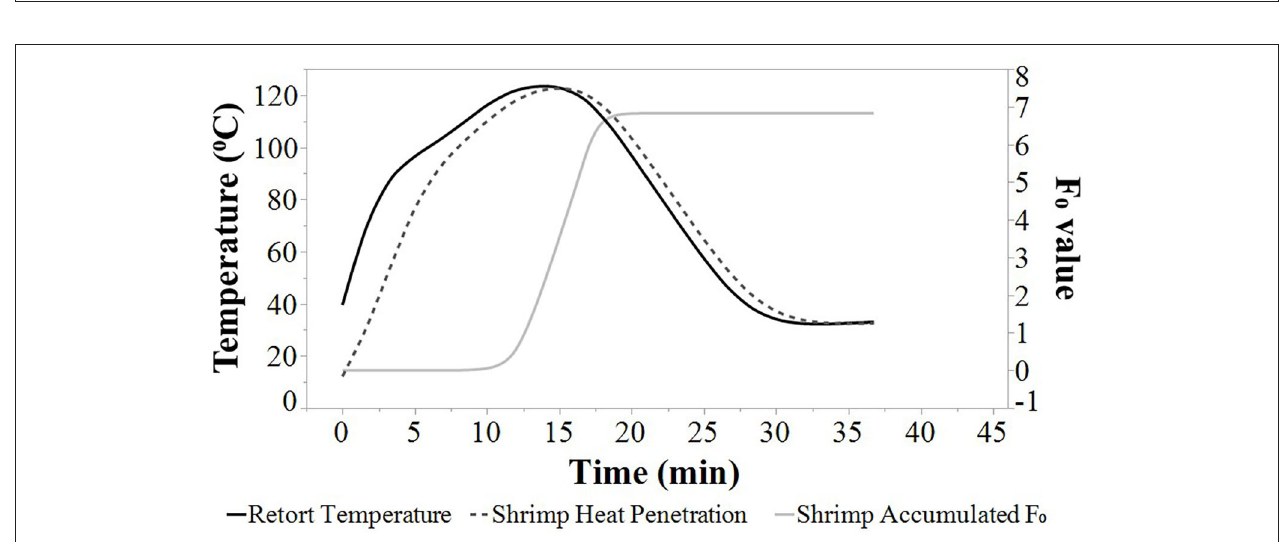
FIGURE 3 | Average retort temperatures (solid black), heat penetration curves (dotted black), and accumulated F 0 (solid gray) values for Louisiana Gulf Coast (LGC) brown shrimp during retort thermal processing at 90 SPM. JMP smoother function was used to construct all figure lines.